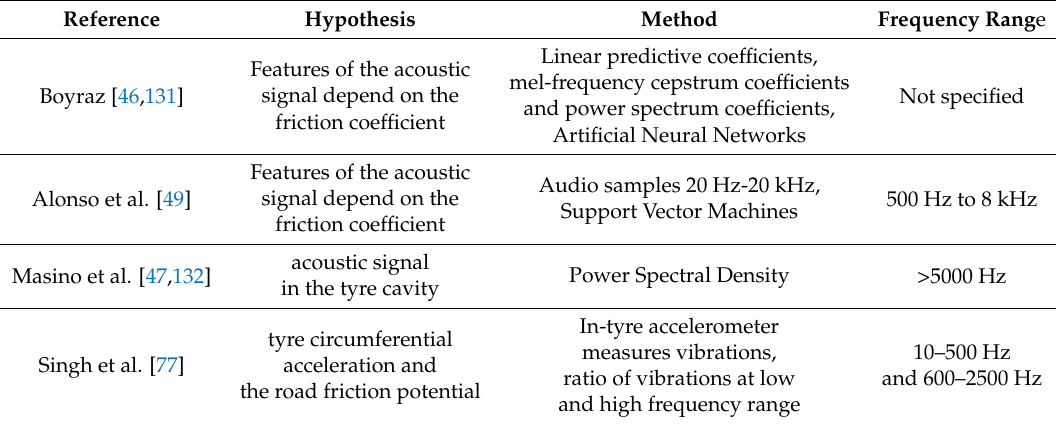
Table 7. Summary of high frequency vibration contributions on friction